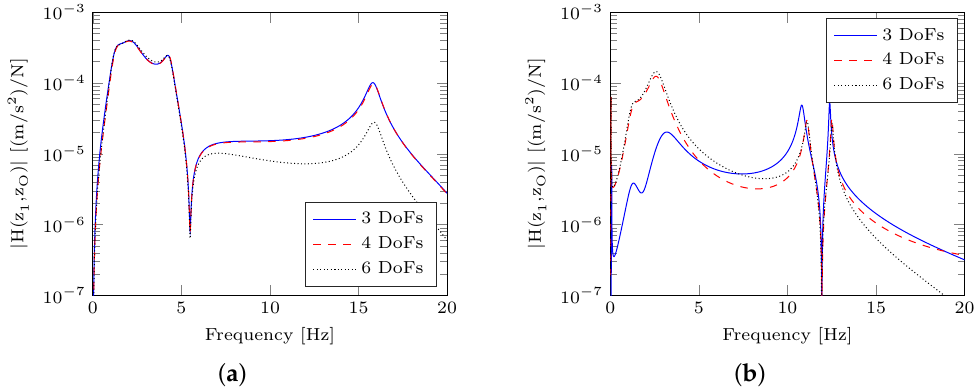
Figure 10. Inertance of different tractors for a force acting on the CoG of the operating machine z O and the response measured on the operating seat z 1 : ( a ) for a rear-mounted machine; ( b ) for a front-mounted